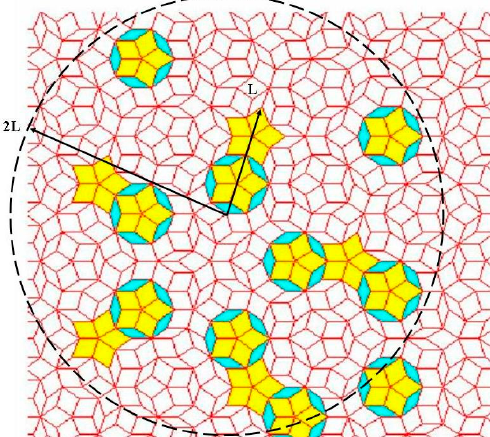
Figure 7. Illustration of Conway’s theorem in a Penrose tiling: Given an arbitrary pattern of tiles (indicated by L in the picture) one will always find a replica of it at a distance smaller than twice its length (dashed circle).